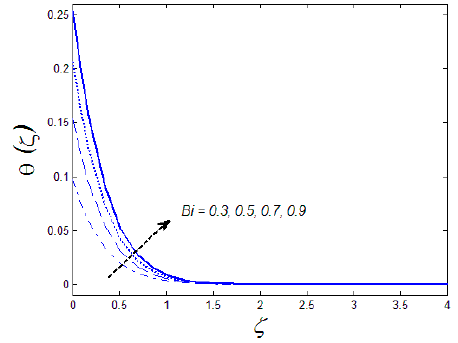
Figure 8. Upshot of Bi on temperature field θ ( ζ ) .